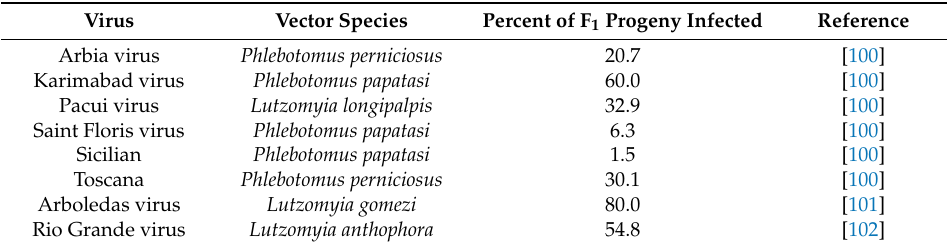
Table 1. Filial infection rates of sand fly-borne